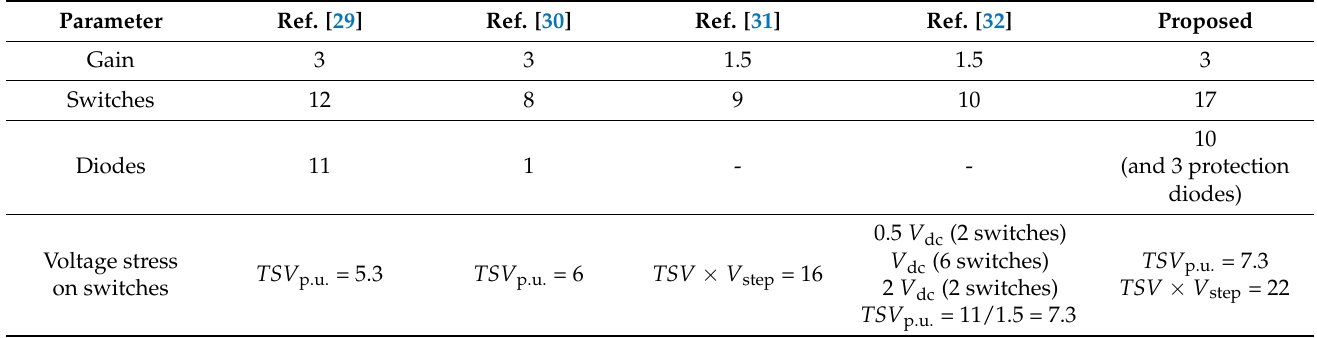
Table 4. Comparison of the proposed converter to switched-capacitor 7-level boost-inverters (the type of total standing voltage TSV coefficients specified as in cited